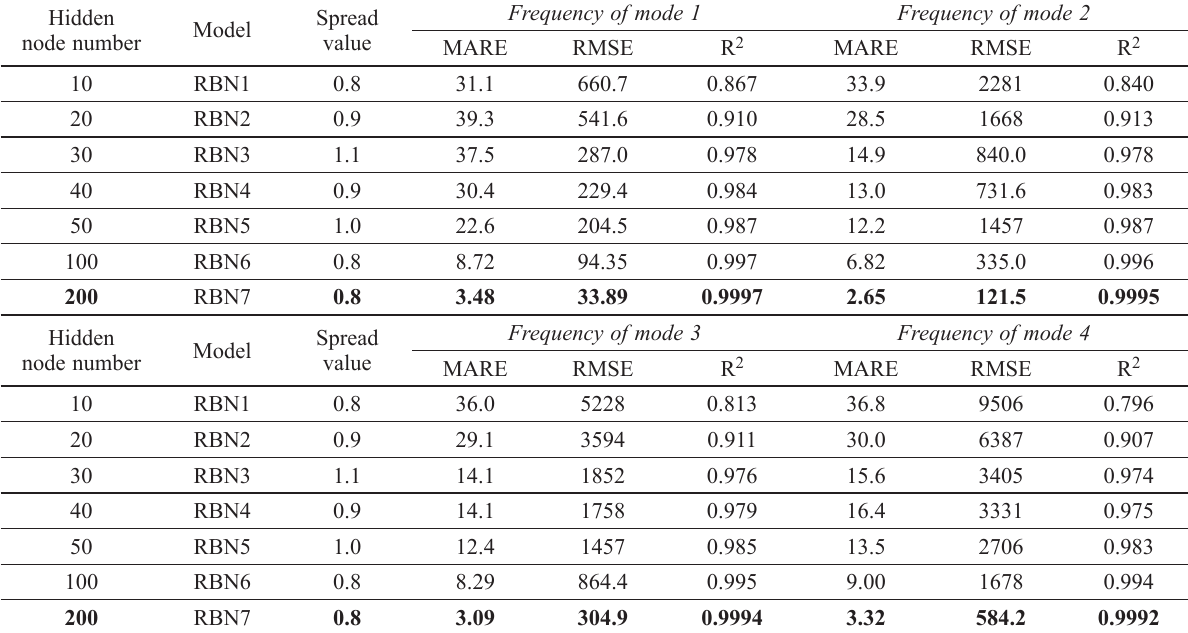
Table 3. The test results of the RBNN models in natural frequency estimation Spread Hidden Model node number